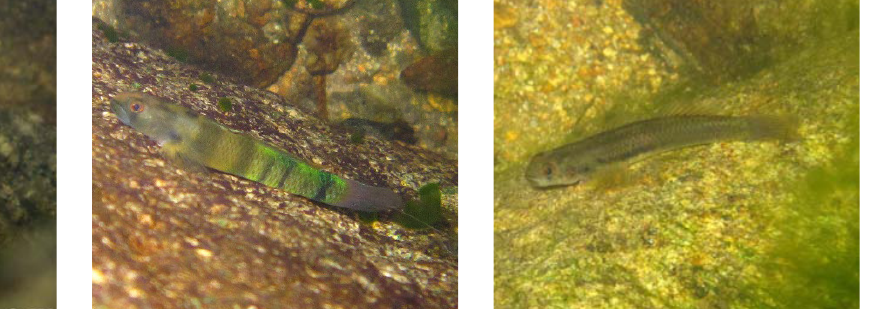
Image 19 Sicyopus zosterophorum